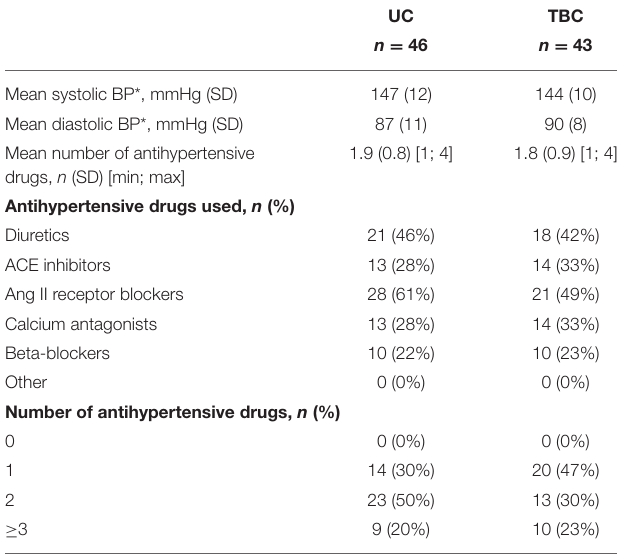
TABLE 2 | Baseline blood pressure (BP) and treatment for